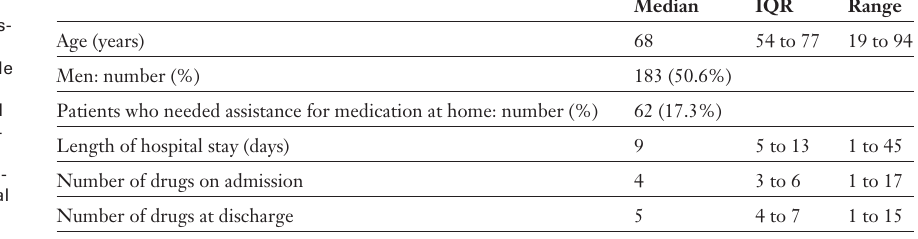
Table 1 Patients’ characteris- tics (n = 362). Median, interquartile range (IQR) and range are displayed for continuous vari- ables. Count and proportions are pro- vided for categorical